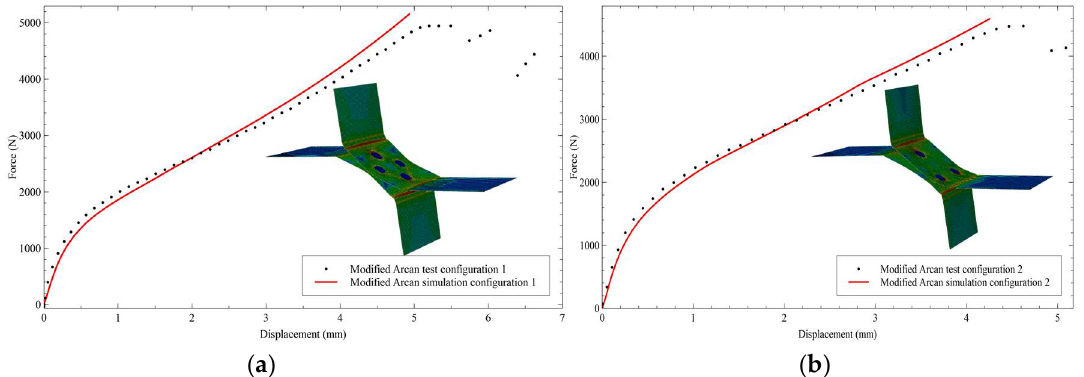
Figure 4. Numerical and experimental force displacement results: ( a ) Configuration 1; ( b ) Configuration 2.